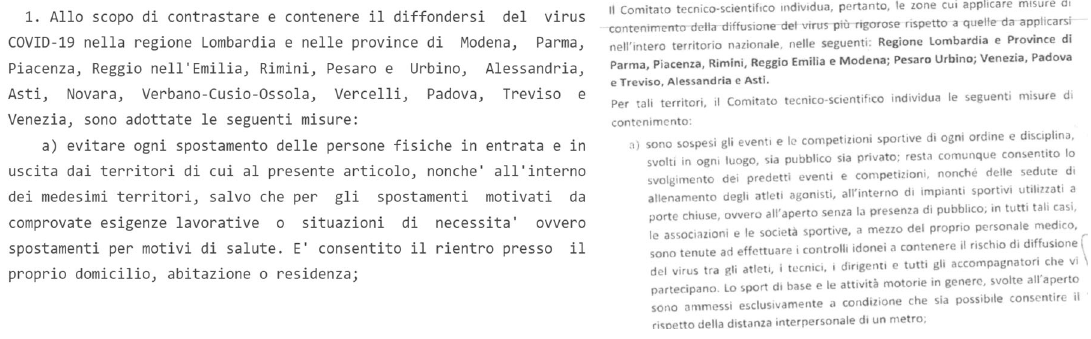
Fig. 5 The unique 'copy and past' feature of expert advice into policy in the fi rst phase of the epidemic in Italy in 2020, as vividely illustrated by